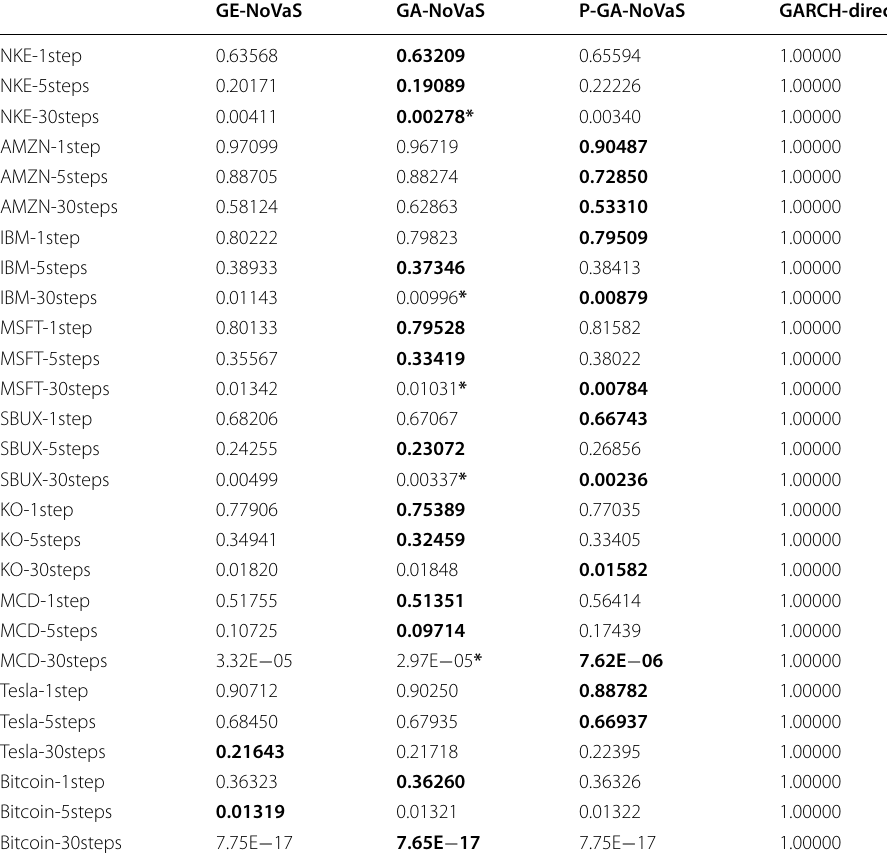
Table 5 Comparison results of using volatile 1-year stock